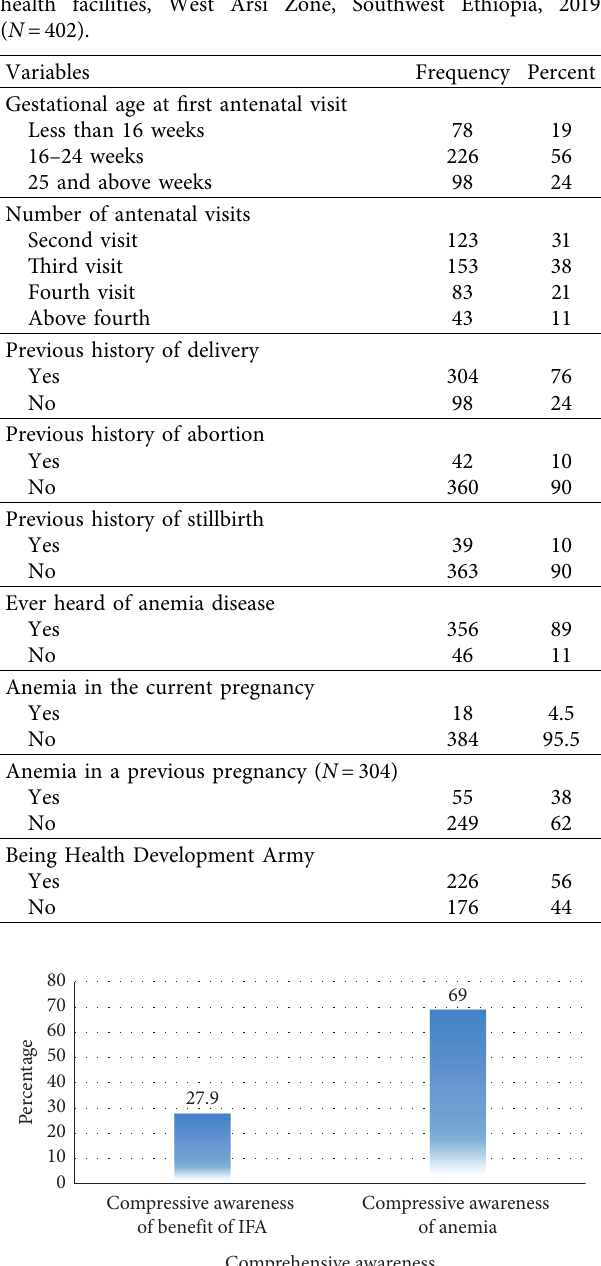
Figure 1: Compressive awareness of the benefit of IFA and anemia, among pregnant women attending antenatal care and taking iron- folate, Shalla district health facilities, West Arsi Zone, Southwest Ethiopia, 2019.